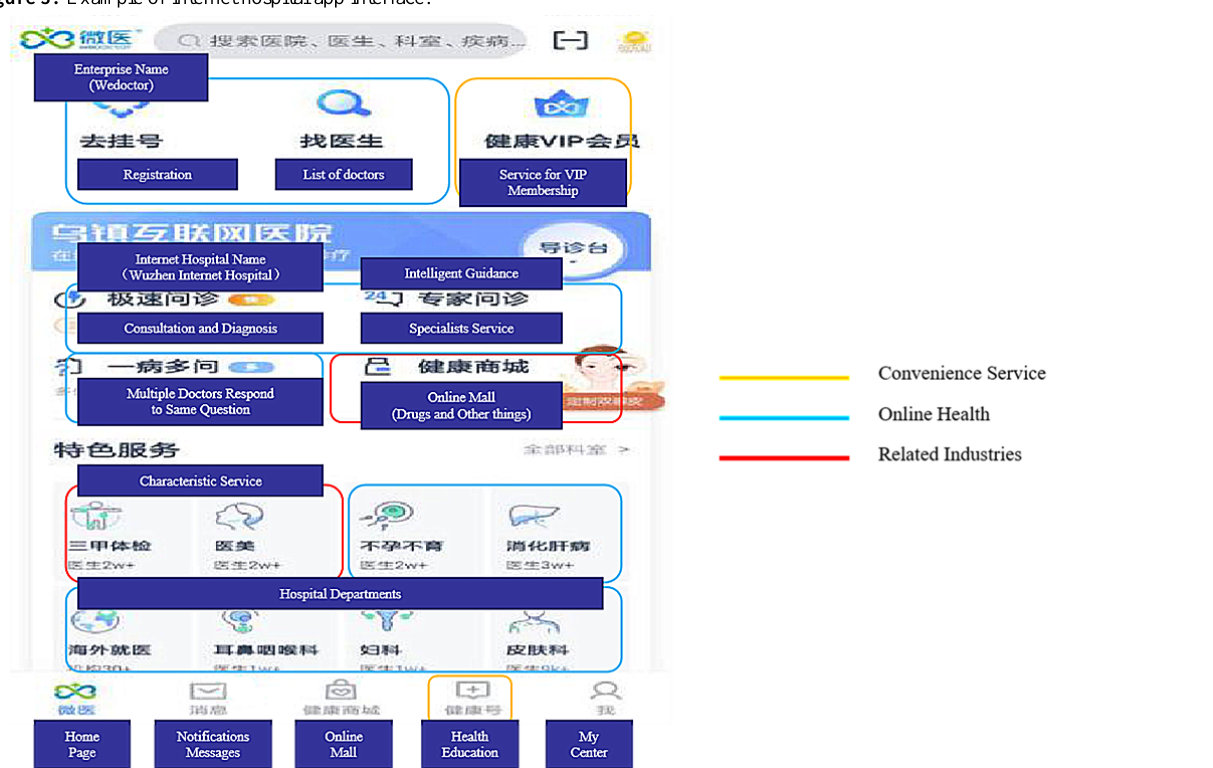
Figure 3. Example of internet hospital app